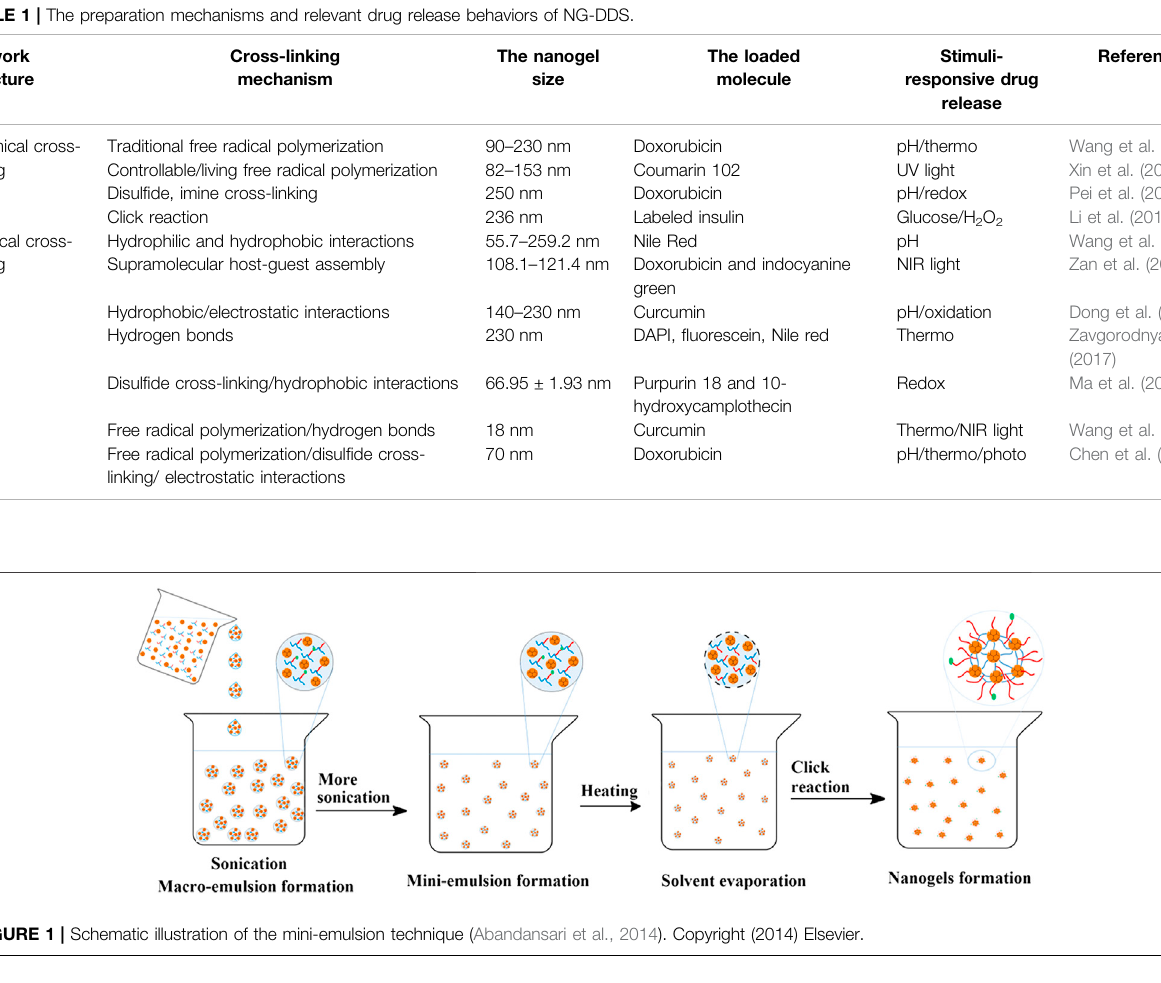
Frontiers in Bioengineering and Biotechnology |